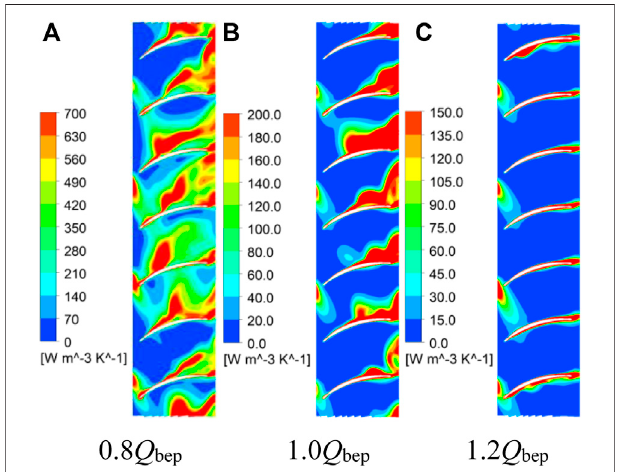
FIGURE 16 | Distribution of entropy production loss in guide vane.